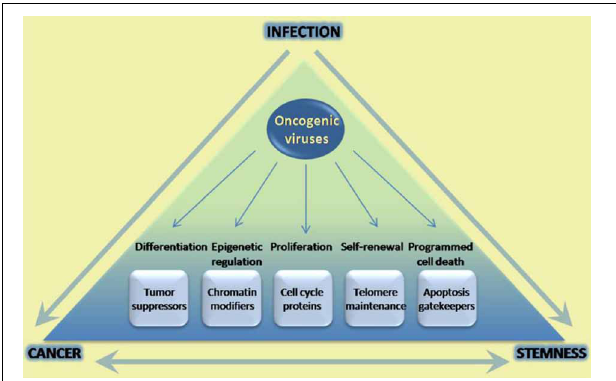
FIGURE 1 | Infection with oncogenic viruses highlights parallels in cancer and stem cell biology. Oncogenic viruses modulate a variety of cellular pathways with parallel roles in the carcinogenic process and stem cell homeostasis. The parallels between these two processes have been extensively documented, and increasingly well-understood in terms of being able to reprogram cell state. However little has been done in the way of uncovering potential roles of these pathways in infection success. Increasing understanding of common pathways modulated may yield better tools to prevent and treat infection, as well as ensuing